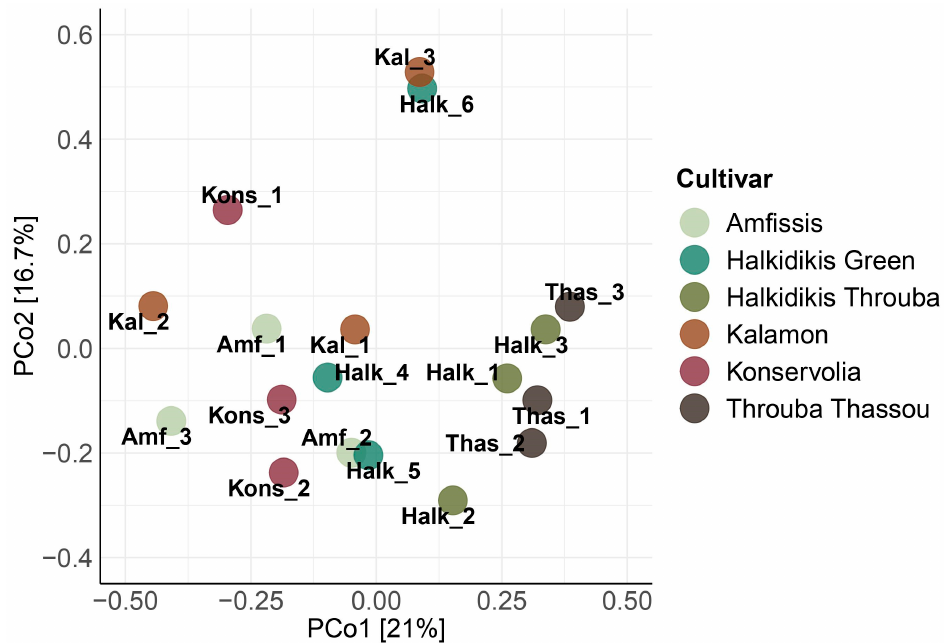
Figure 4. Principal coordinates analysis (PCoA) for the 18S rRNA amplicon metabarcoding data for all samples.